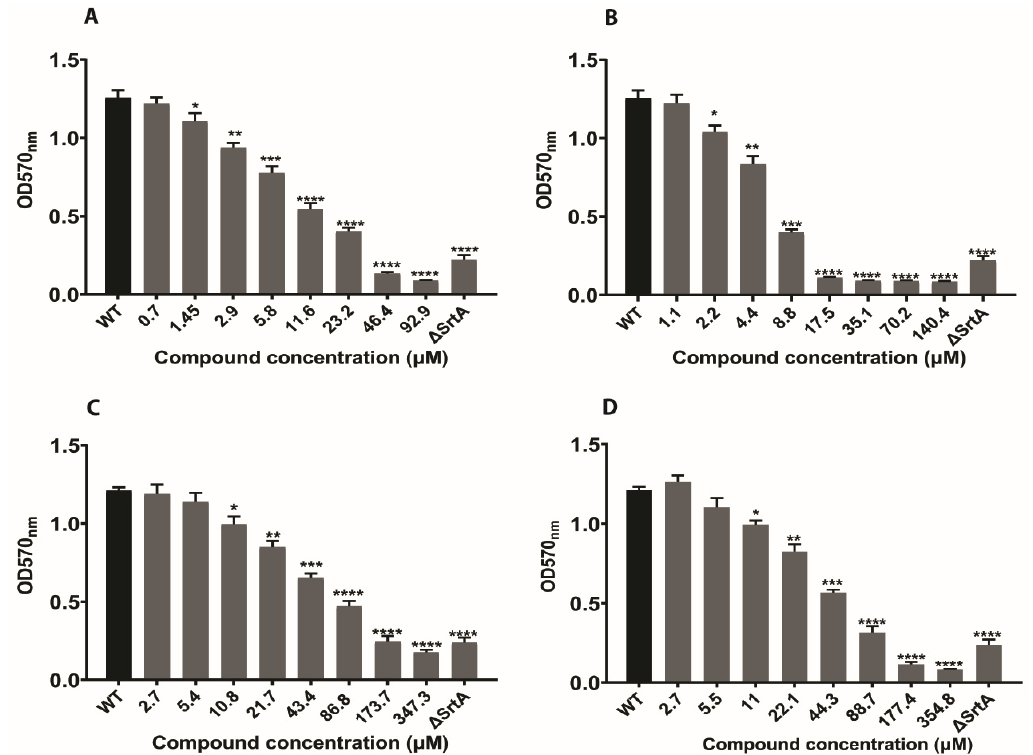
Figure 8. E ff ects of SrtA inhibitors on the adherence of S. aureus cells (strain Newman) to fibrinogen protein. N1287 ( A ), N2576 ( B ), curcumin ( C ), and p-HMB ( D ). The results are presented as the mean absorbance at 570 nm ± S.E of three replicates (two independent experiments) relative to the untreated control (wild type). * p < 0.05, ** p < 0.01, *** p < 0.001 and **** p < 0.0001.